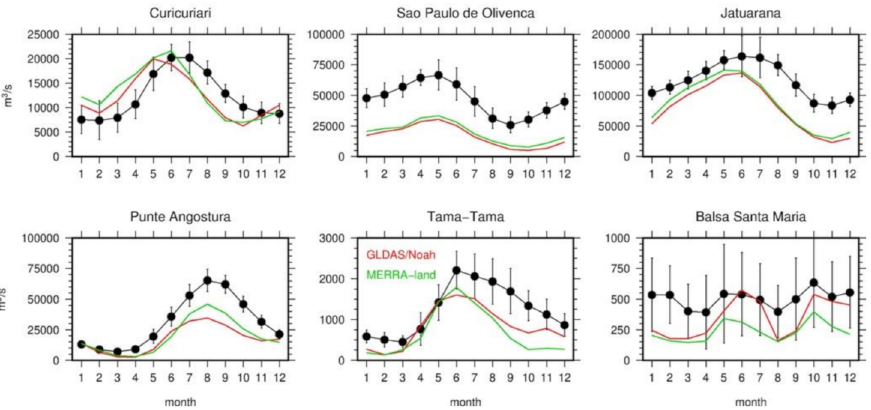
Figure 2. Mean annual measured (in black) and modeled (in red with GLDAS/Noah runoffs and in green with MERRA-land) annual discharged for three gauges in the Amazon river basin ( top ), and two in the Orinoco and Parana river basins ( bottom ). The location of the gauges is given in Figure